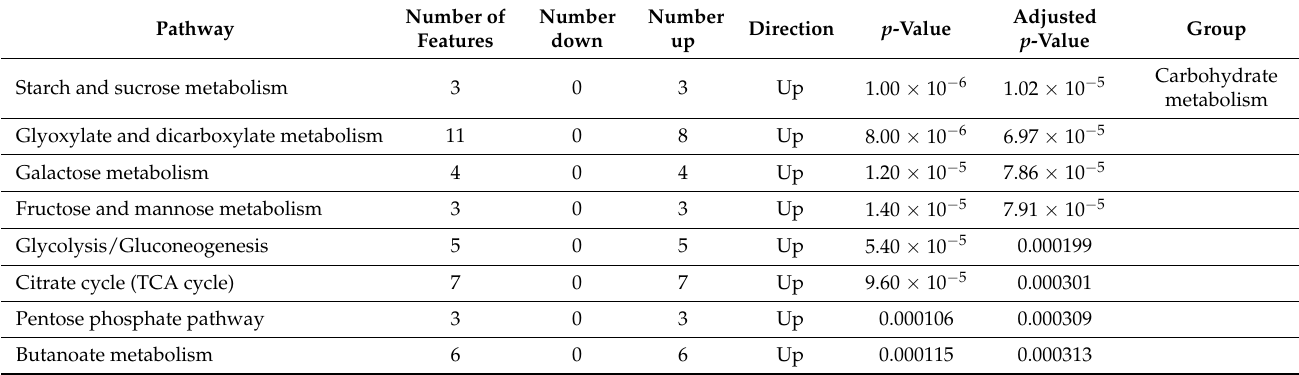
Figure 5. Graphical representation of the pathway enrichment results. Each dot represents a pathway, for which the x-axis represents the proportion of deregulated metabolites and the y-axis the adjusted p -value. The size of each dot is proportional to the number of identified metabolites present in the respective pathway, and the dot color indicates pathway up (red) or down (blue) regulation. Table 3. List of the 41 KEGG metabolism pathways for which at least three identified metabolites were measured. For each pathway, its name, number of up- and downregulated features, raw p -value, and adjusted p -value are reported. Based on the adjusted p -value, 31 of the listed metabolic pathways were significantly altered in the Mecp2 − /y cortex.